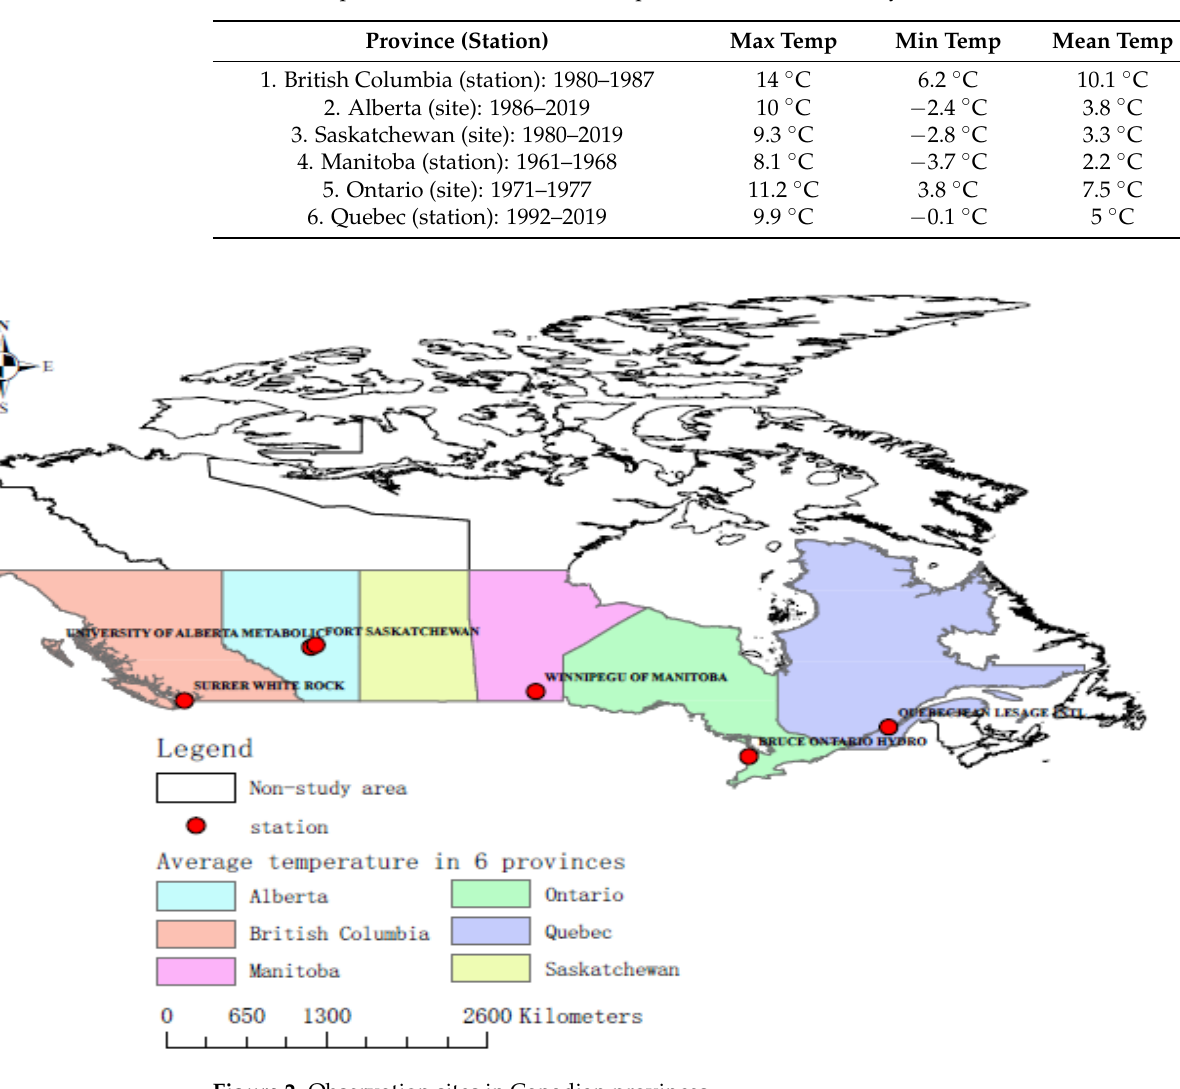
Table 4. Temperatures in the six Canadian provinces (sites) over the years.